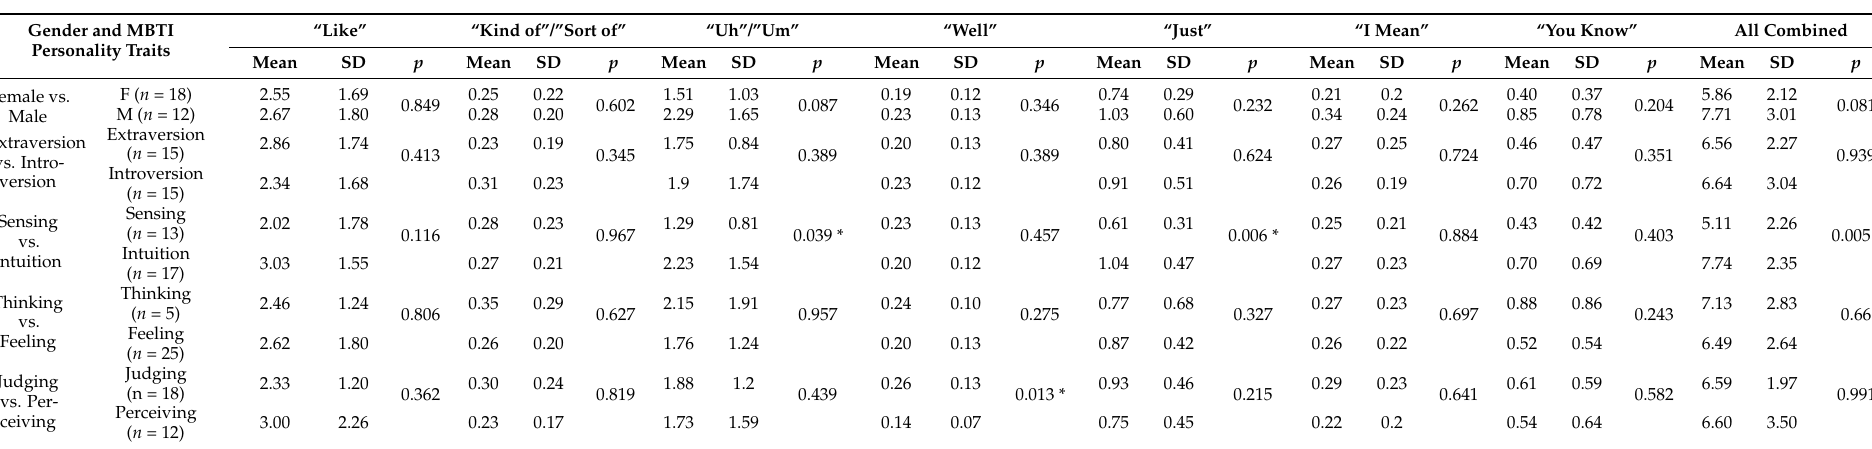
Table 3. Statistical analysis results ( p -values) on the use of discourse markers (frequency in